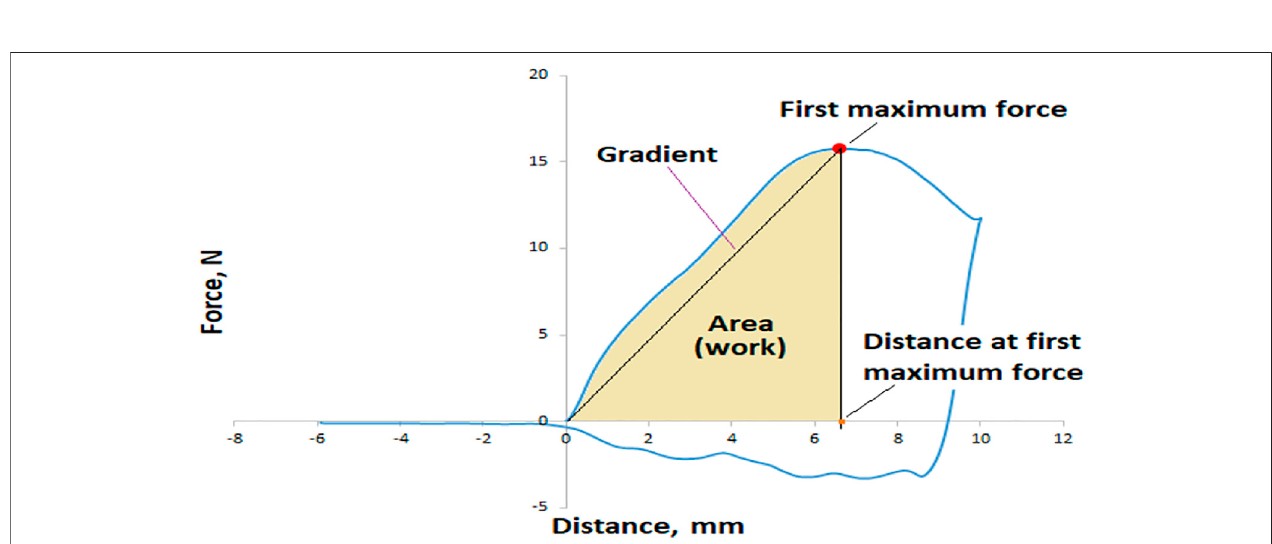
FIGURE 2 | Typical force-deformation curve for date fruit texture